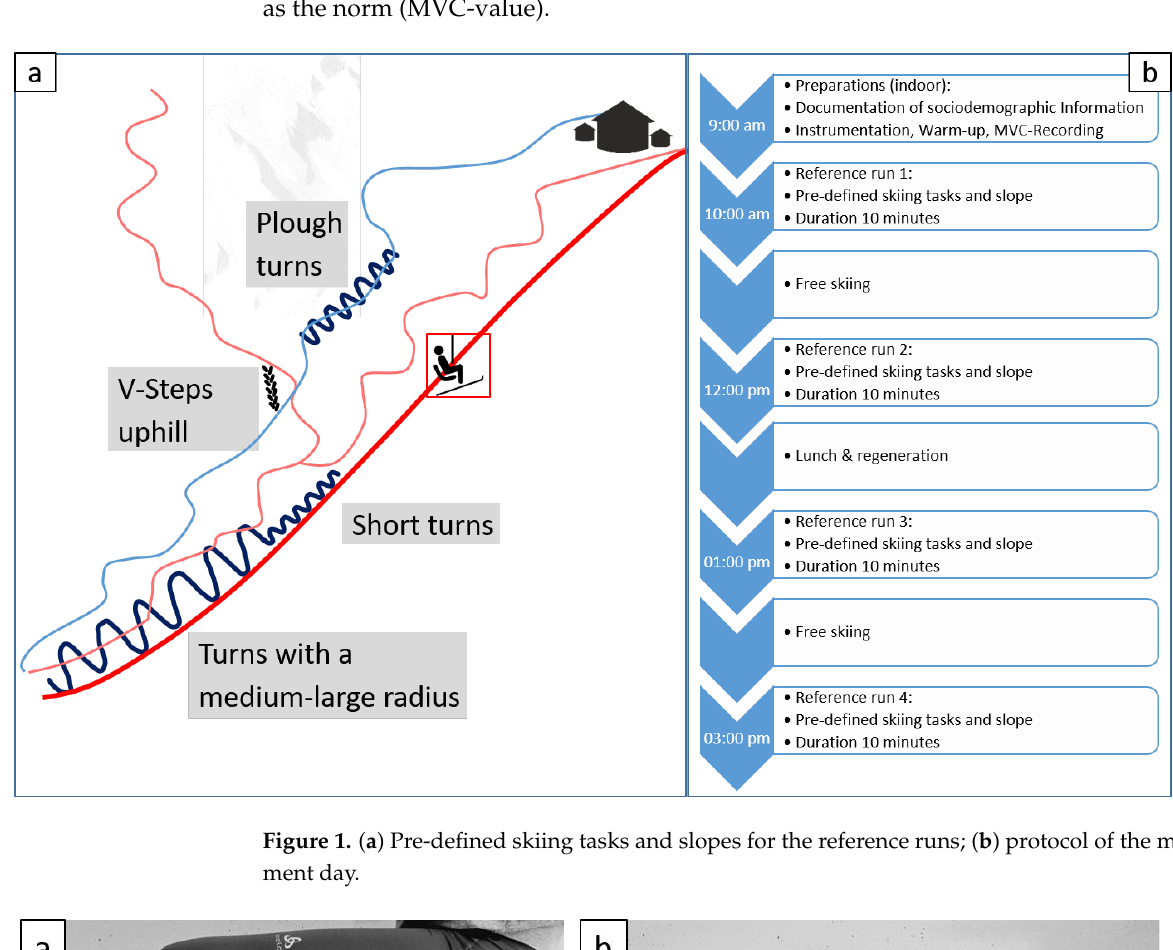
Figure 1. ( a ) Pre-defined skiing tasks and slopes for the reference runs; ( b ) protocol of the measure- ment day.